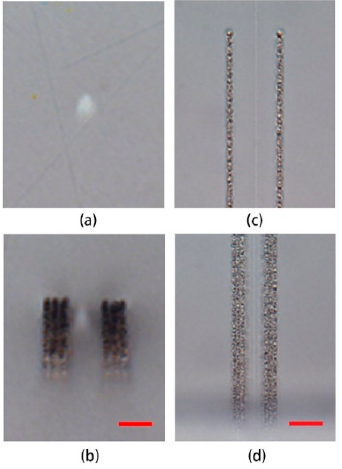
Figure 2. Optical microscopic images of the end-face cross sections of the femtosecond-laser direct-writing waveguides ( a ) without and ( b ) with tapered structure for D1 = 6 µ m (scale bar: 10 µ m), and the top view microscopic images ( c ) at the narrower end and ( d ) at the wider end of the taper (Scale bar: 20 μ m).